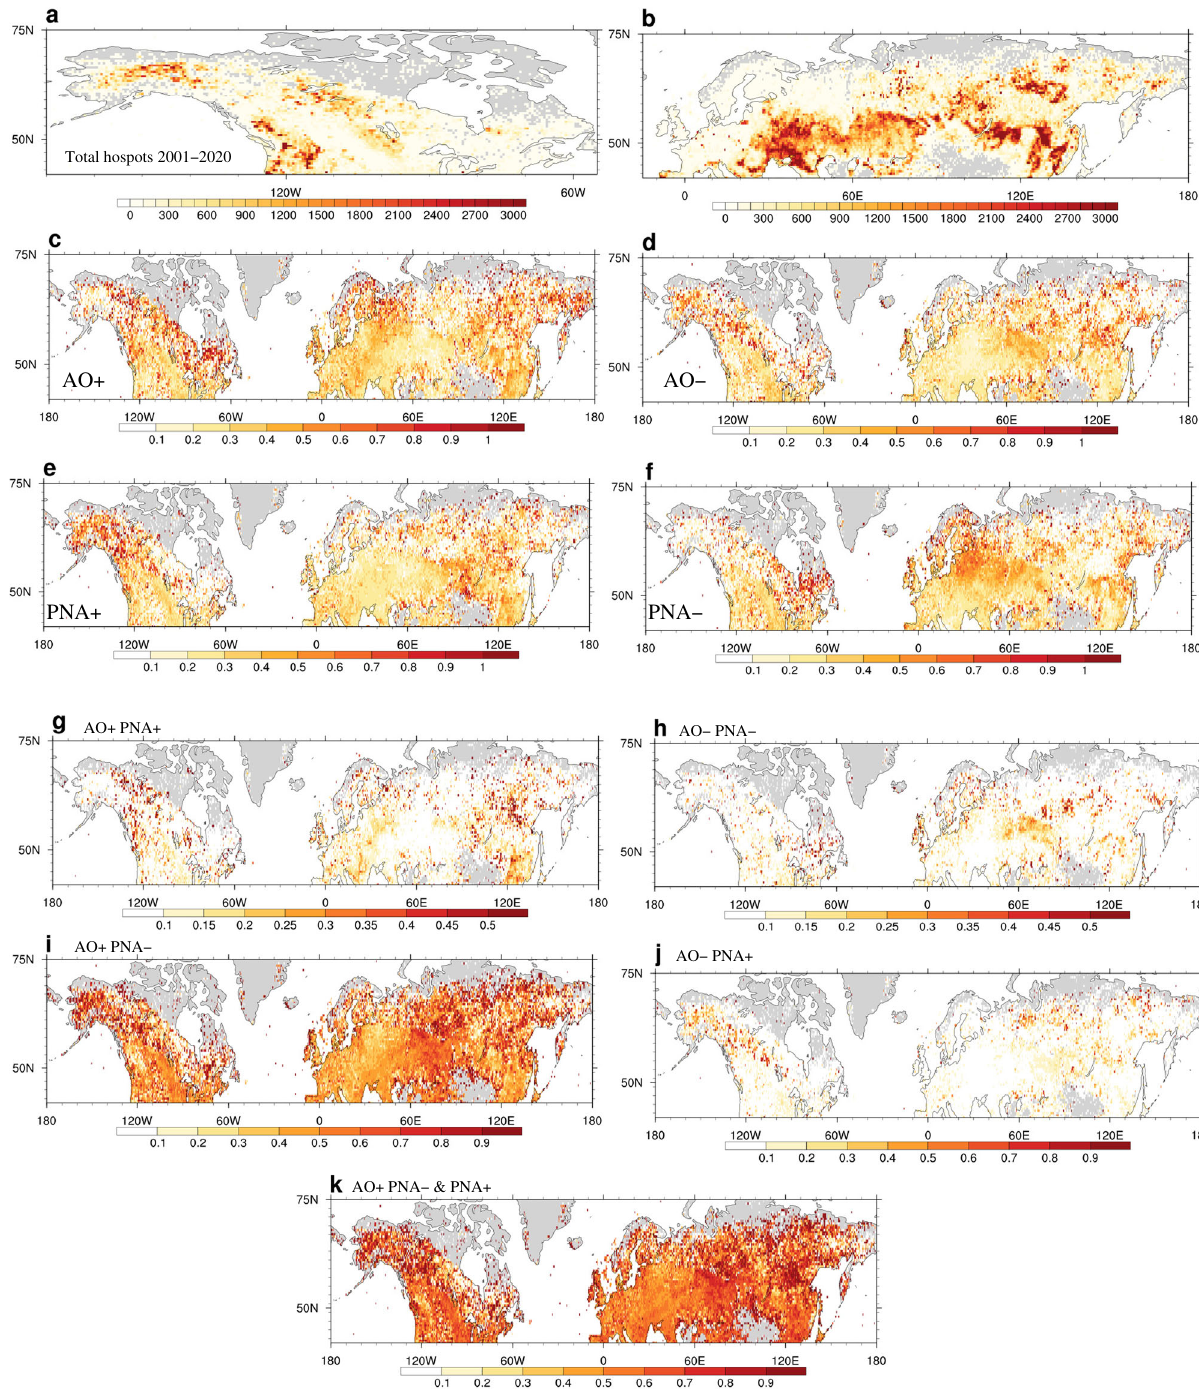
Fig. 5 Fire distribution and AO/PNA. Accumulated number of satellite-observed fi res between March and October during 2001 – 2020 ( a , b ). c and d shows the ratio between fi res during AO + , AO and the total accumulated in the period. e , f is the same as ( c ), ( d ) but for PNA + and PNA. g Shows the ratio but for AO + and PNA + and h for AO and PNA. i AO + and PNA. j AO and PNA, k is the sum of ( g ) and ( i ). Labels in j range from 0.1 to